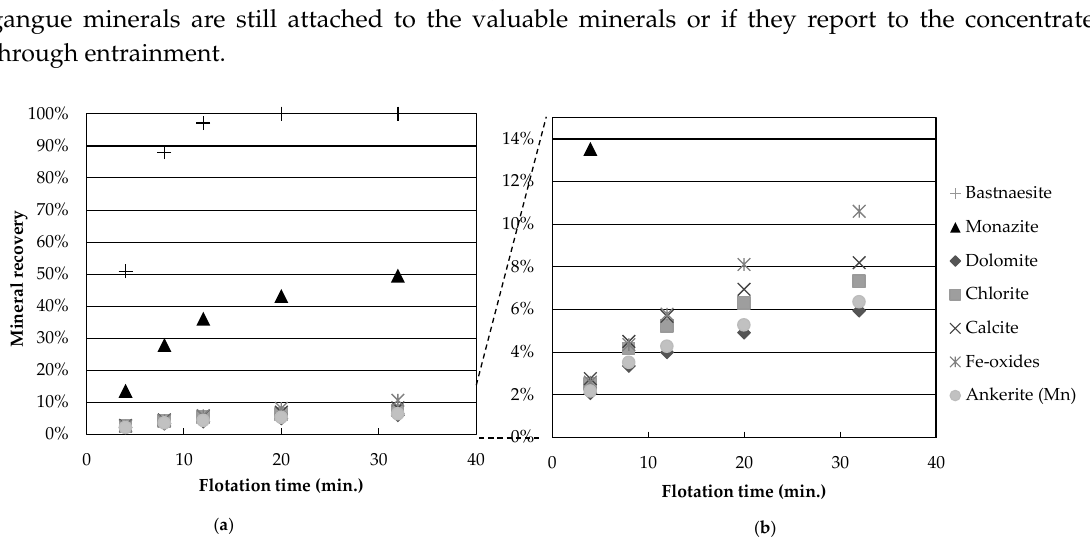
Figure 3. Mineral recovery as a function of time for experiment 4 (75 ◦ C, 2400 g/t Na 2 SiO 3 , 0 g/t guar gum). ( a ) Overall; ( b ) Close-up on gangue